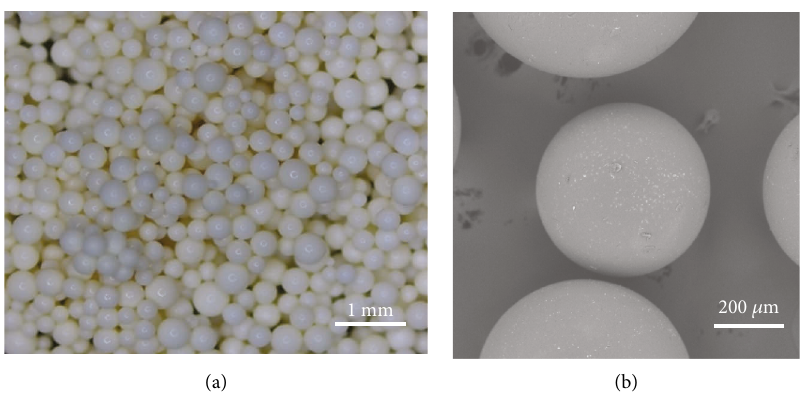
Figure 2: (a) Digital photo of CAPS beads and (b) its SEM